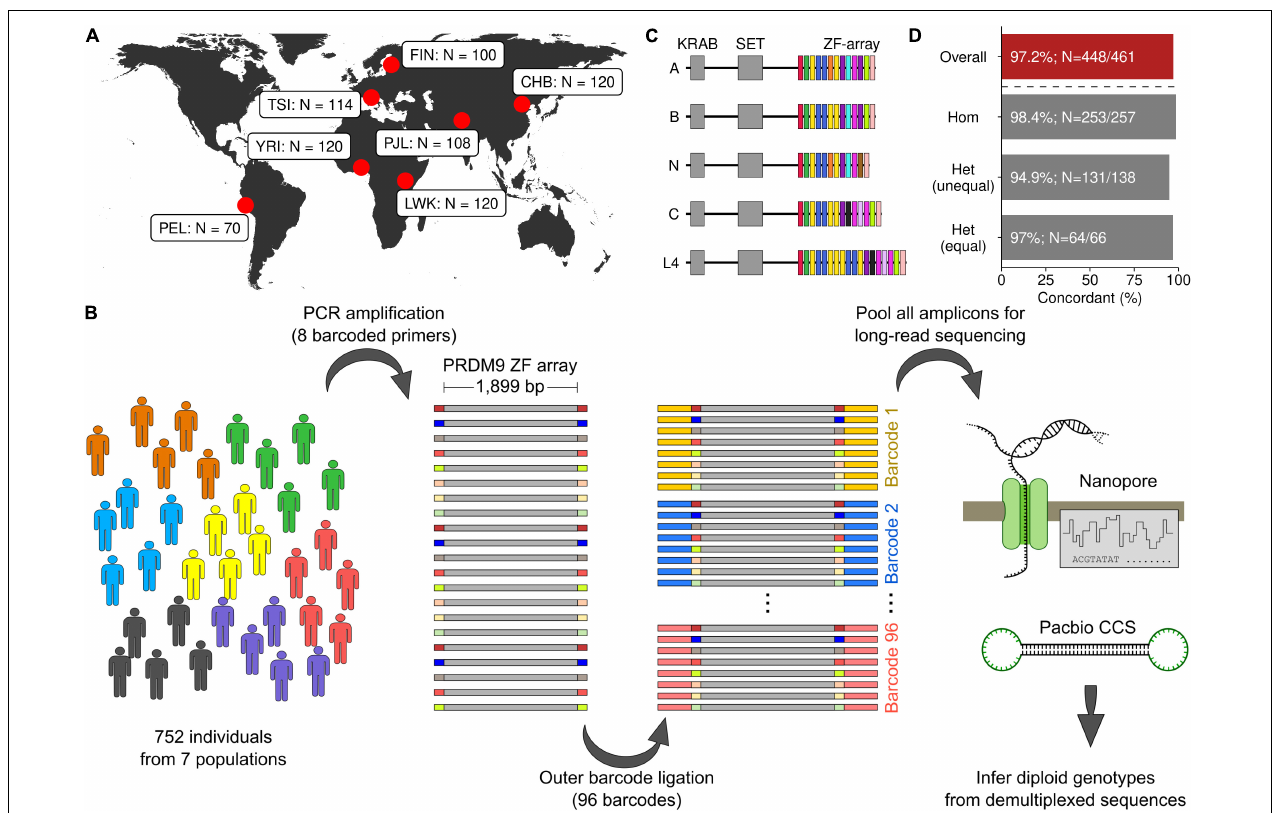
FIGURE 1 | PRDM9 diploid genotyping with long-read sequencing. (A) Geographic location of seven populations in this study (YRI, Yoruba in Ibadan, Nigeria; LWK, Luhya in Webuye, Kenya; TSI, Toscani in Italia; FIN, Finnish in Finland; PEL, Peruvian in Lima, Peru; CHB, Han Chinese in Beijing, China; PJL, Punjabi in Lahore, Pakistan). (B) Schematic of amplification, barcoding, and sequencing strategy (see section “Materials and Methods”). (C) The protein domain structure of human PRDM9. The zinc finger (ZF) array of PRDM9 is a repeating array of 84-bp-long ZFs. ZF variants are indicated by different colors. Five annotated PRDM9 alleles are shown. (D) Genotyping PRDM9 gives analogous results using either Oxford Nanopore or Pacific Biosciences Circular Consensus Sequencing (CCS) (PacBio CCS). The percentage of concordant genotypes is shown. The least agreement (94.9%) is seen for individuals that are heterozygous for alleles of different lengths